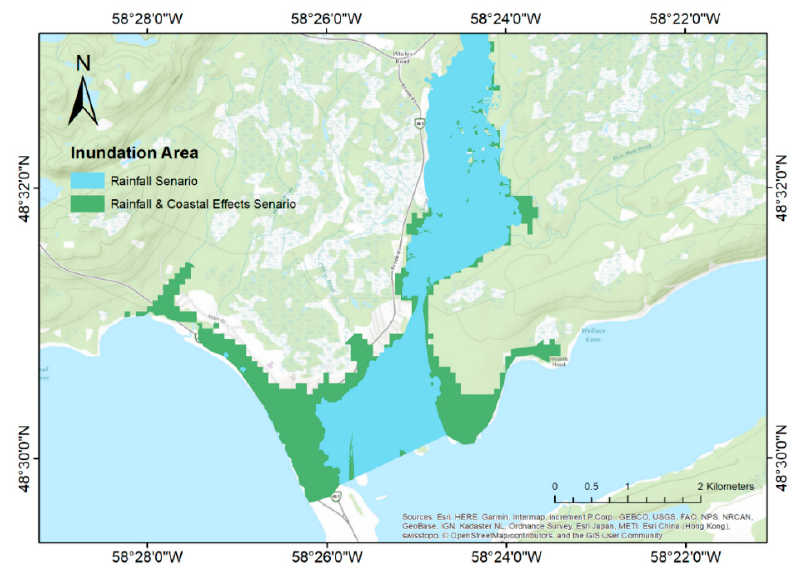
Figure 11. Flood inundation areas corresponding to fluvial flooding (blue) and compound fluvial and coastal flooding (blue and